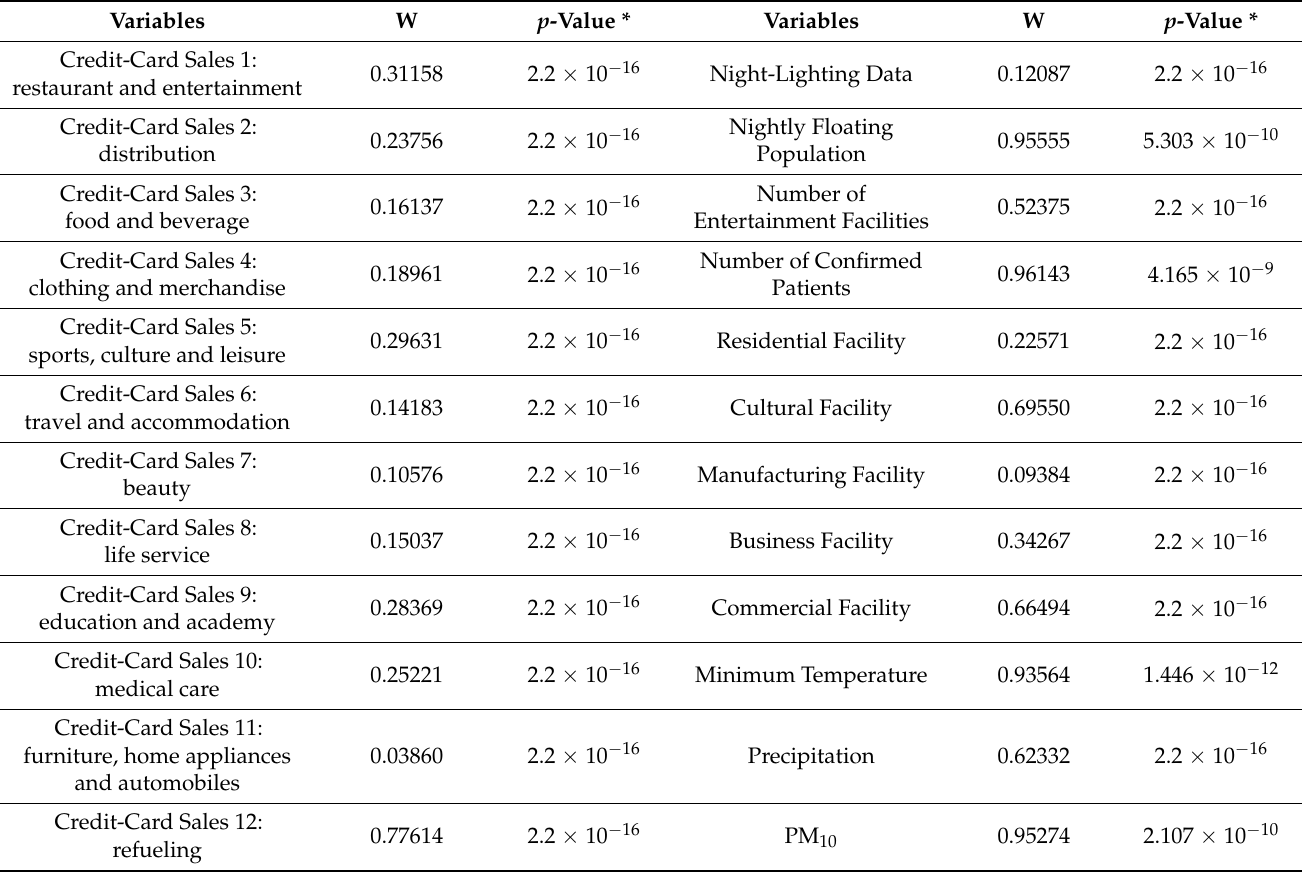
Table 4. Shapiro-Wilk analysis